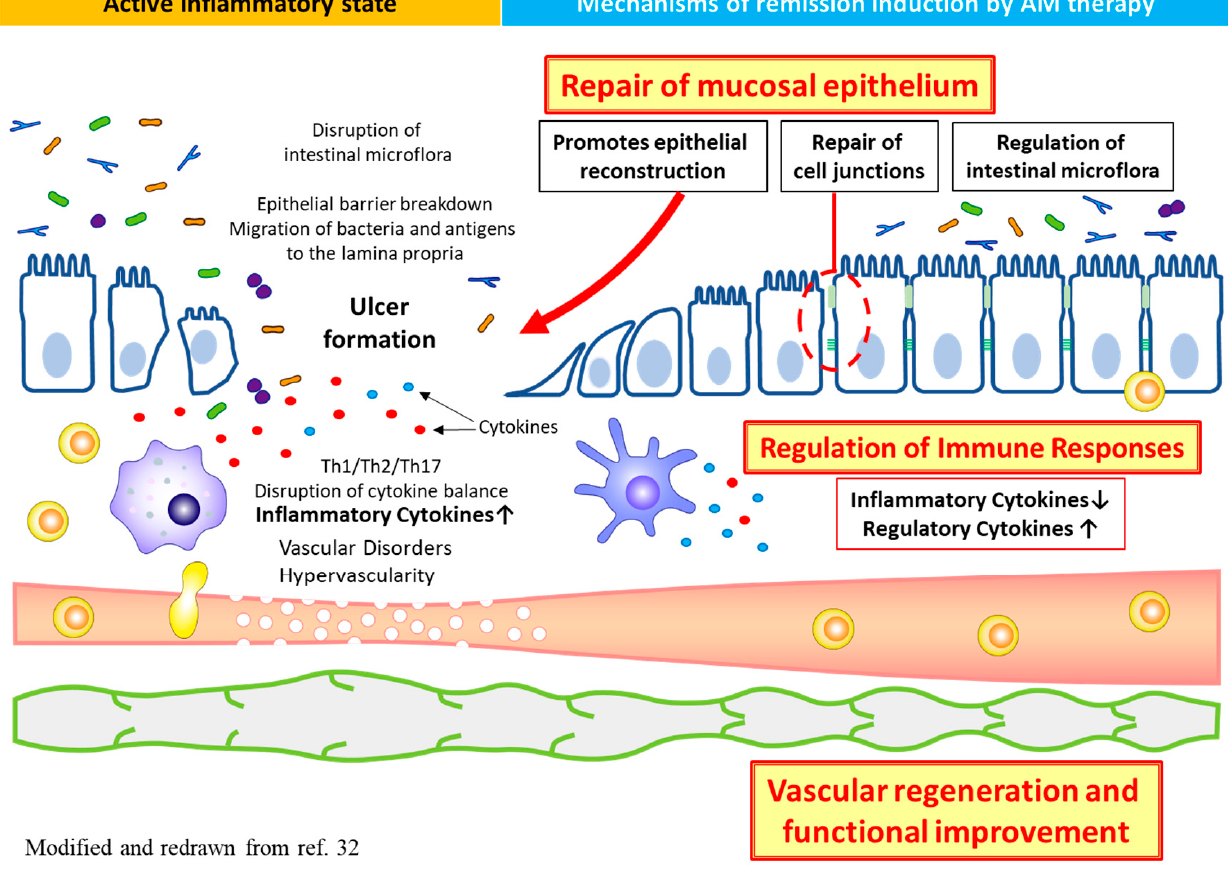
Figure 4. Pathophysiology of IBD and therapeutic targets of AM therapy.